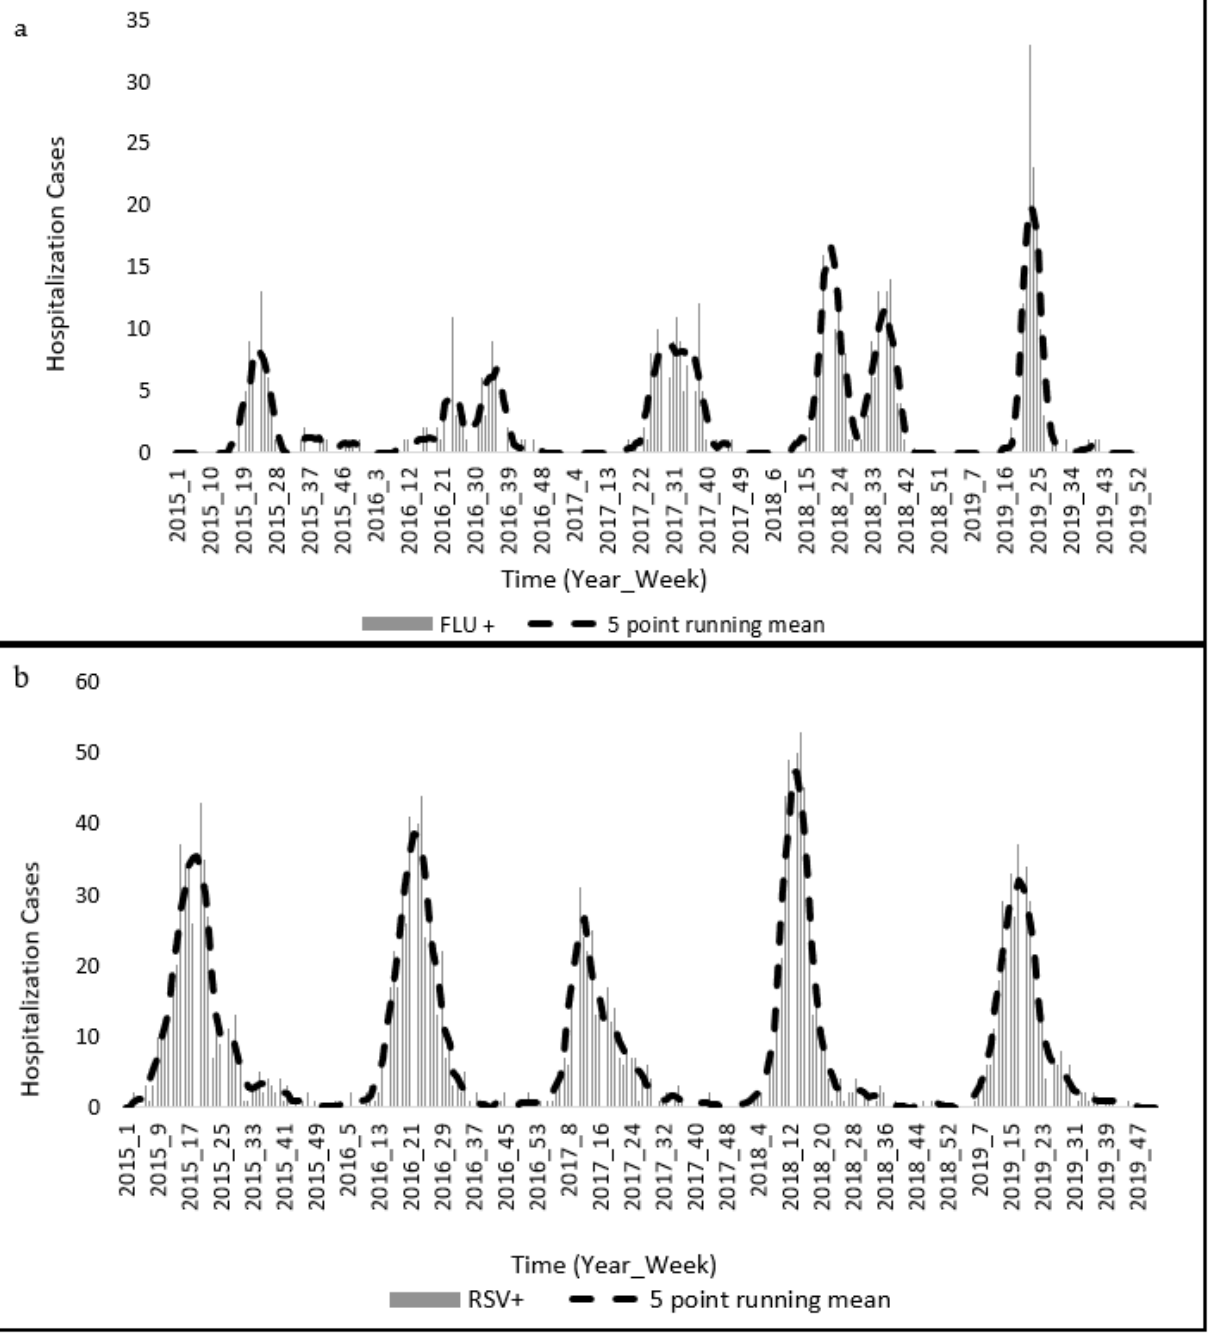
Figure 2. Caseloads of hospitalized patients with positive tests for ( a ) influenza and ( b ) RSV (2015–2019).